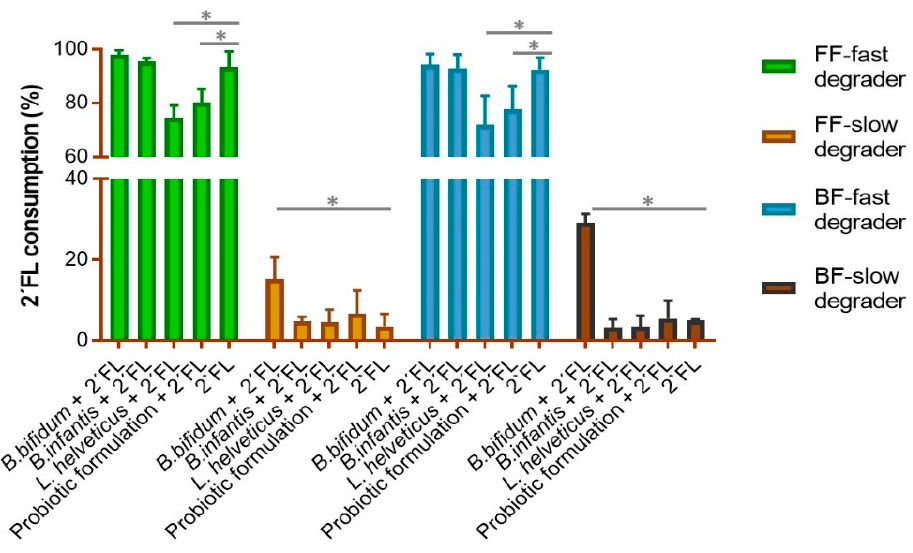
Figure 1. 2 (cid:48) FL consumption (% of decrease in the levels of 2 (cid:48) FL from values at baseline, considered as 100%) by fecal cultures with added probiotics plus 2 (cid:48) FL with respect to fecal cultures only, with 2 (cid:48) FL added after 24 h of incubation for each of the four fecal culture groups previously defined for the same fecal inocula according to the feeding type of donors and intrinsic capacity of the basal microbiota to degrade 2 (cid:48) FL: FF-fast degrader, FF-slow degraders, BF-fast degraders, BF-slow degrader. Significant differences between 2 (cid:48) FL cultures and those with each added probiotic and the probiotic formulation plus 2 (cid:48) FL are indicated by asterisks over bars. * p -value <